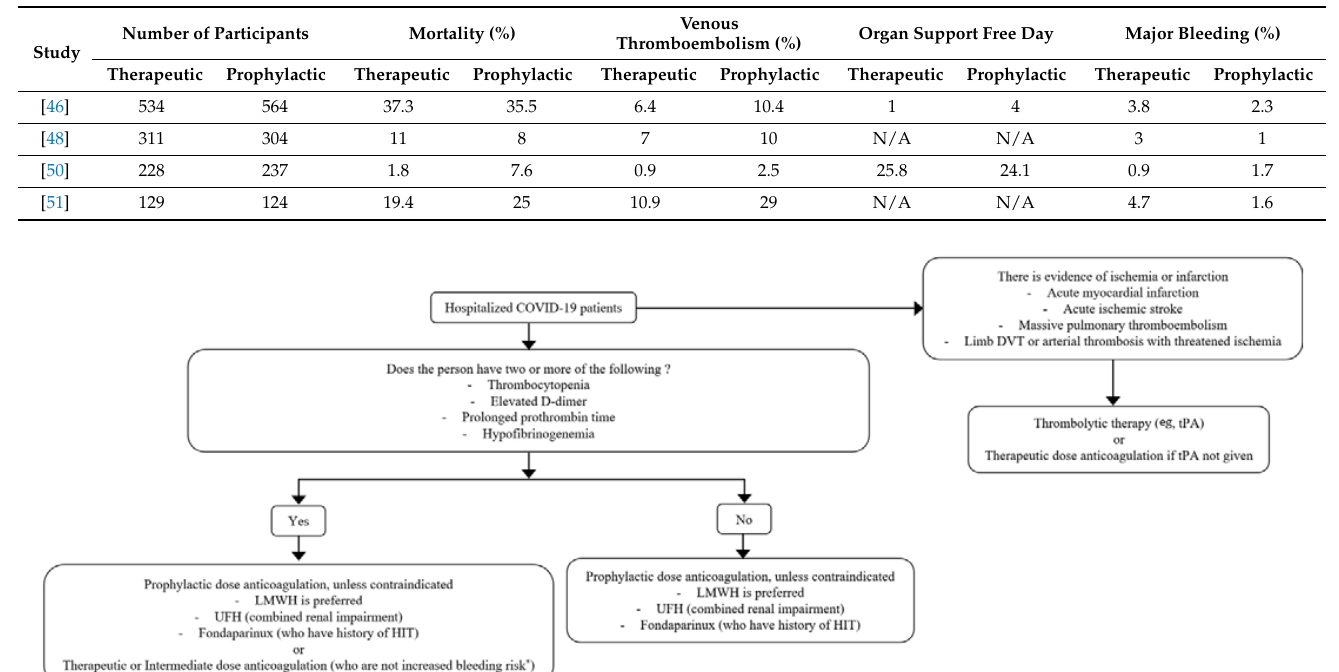
Table 2. Comparison of the effectiveness of therapeutic-dose and prophylactic-dose anticoagu- lant therapy.